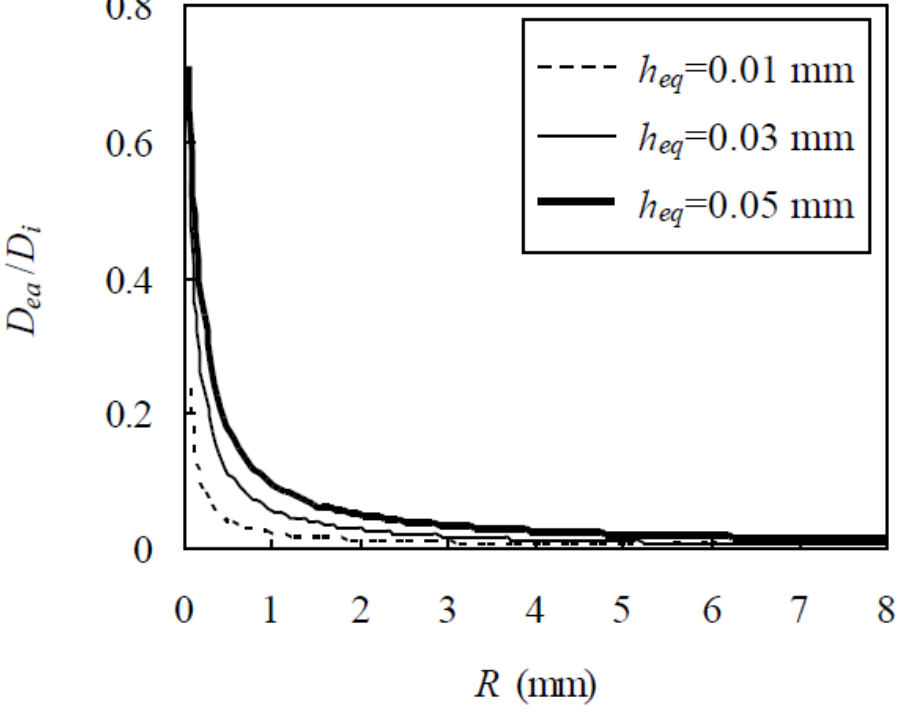
/ D ea i and R for di